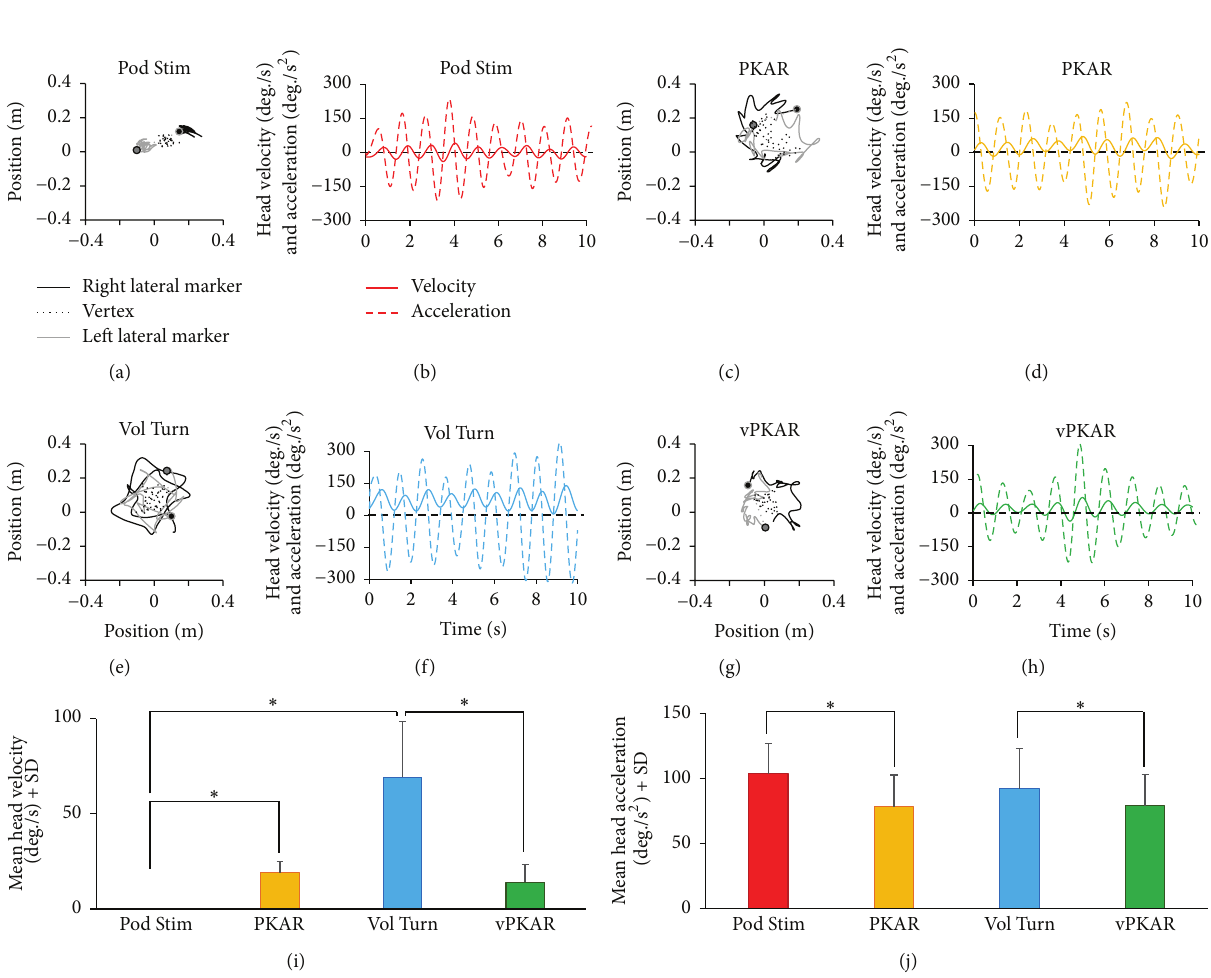
Figure 4: Head angular acceleration. (a) to (h) show the head movements in the horizontal plane during the podokinetic stimulation (Pod Stim, (a)), PKAR (c), voluntary turning (Vol Turn, (e)), and vPKAR (g). The two dots in (a), (c), (e), and (g) indicate the initial positions of the markers placed on the right (black dot) and left (grey dot) side of the head. Head velocity (solid line) and acceleration (dashed line) are reported in (b), (d), (f), and (h). The rotational effect of voluntary turning can be seen by the bias in the angular velocity profile (f). (i) and (j) show the mean values of head velocity (i) and acceleration (j) across subjects. Head showed angular acceleration (j) under both voluntary turning and podokinetic stimulation. There were no differences between the two posteffects for either head velocity or acceleration. ∗ indicates significant difference ( 𝑝 < 0.05 ) between mean head velocities (i) and accelerations